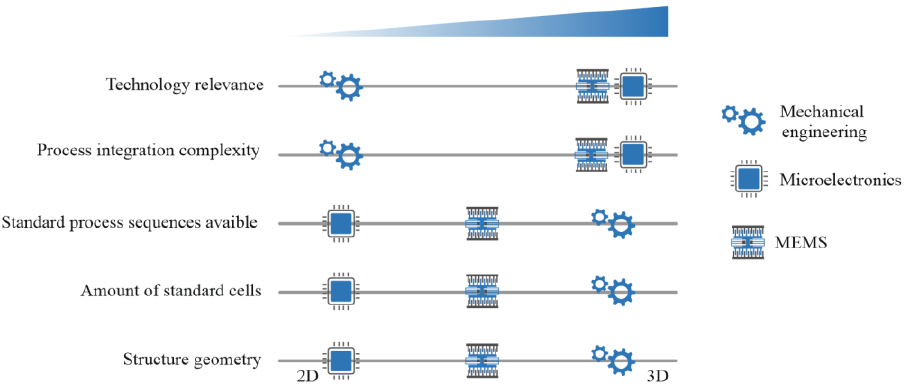
Fig. 11. Comparison of microelectronics, mechanical engineering and MEMS